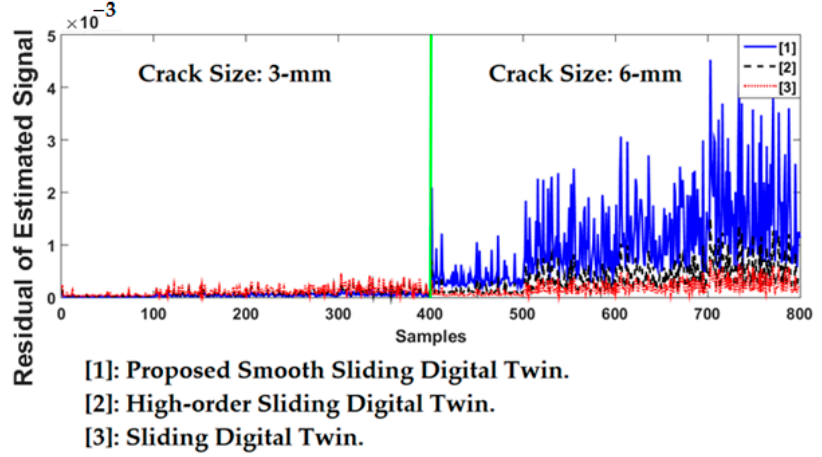
Figure 17. The accuracy of crack size identification for outer residual of RMS signals using proposed smooth sliding digital twin, high-order sliding digital twin, and sliding digital twin.